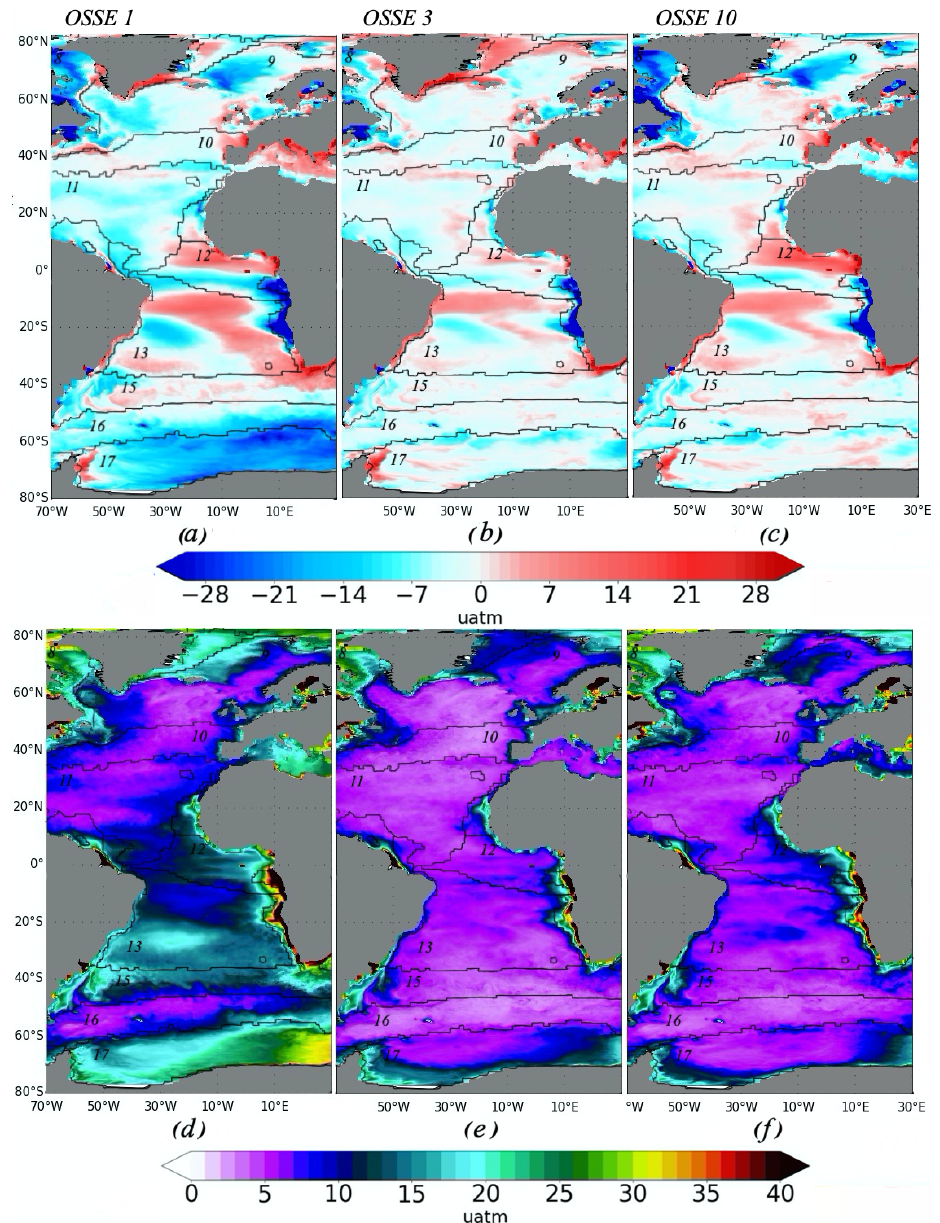
Figure 5. Differences between OSSE FFNN outputs and NEMO/PISCES p CO 2 and its standard deviation (SD; in µatm): (a, b, c) its maximum and minimum values from four outputs for each OSSE FFNN (Eq. 4) and (g, h) standard deviation of differences for all four outputs for each OSSE FFNN (Eq. 5). (a, d) OSSE 1 using SOCAT data only; (b, e) OSSE 3 using SOCAT and synthetic Argo data; and (c, f) OSSE 10 using SOCAT data, 25% of the original synthetic Argo data in the Southern Hemisphere, and data from mooring stations. Contours and numbers on maps correspond to